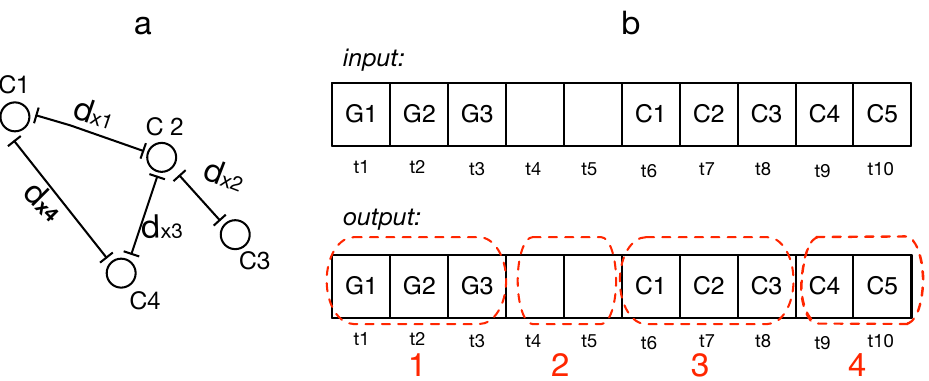
Figure 3. ( a ) Four consecutive locations from Cell-ID; ( b ) four events have been detected, the first three elements contain GPS, and then with two elements marked as unknown. Three later elements, C1, C2, C3 contain cell IDs and show another movement until the point C4. The geographical distance between C4 and both C3 and C2 is less than δ d